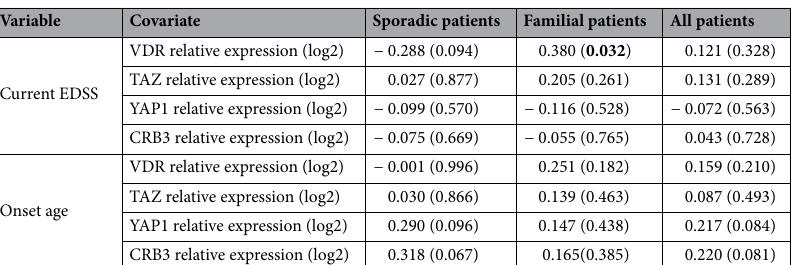
Table 2. Correlation coefficients (and p-values) of relative gene expressions with EDSS and Onset age in patient groups. Bold values denote statistical significance at the p < 0.05 level.